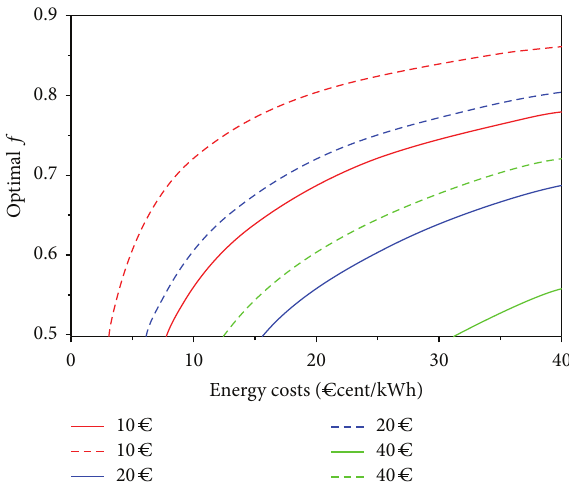
Figure 3: The economically optimal value for 𝑓 as function of the energy price in Ccent / kWh. The different colors indicate different values for the membrane price. Full lines indicate a membrane quality of 2 W/m 2 , and dashed lines indicate 5 W/m 2